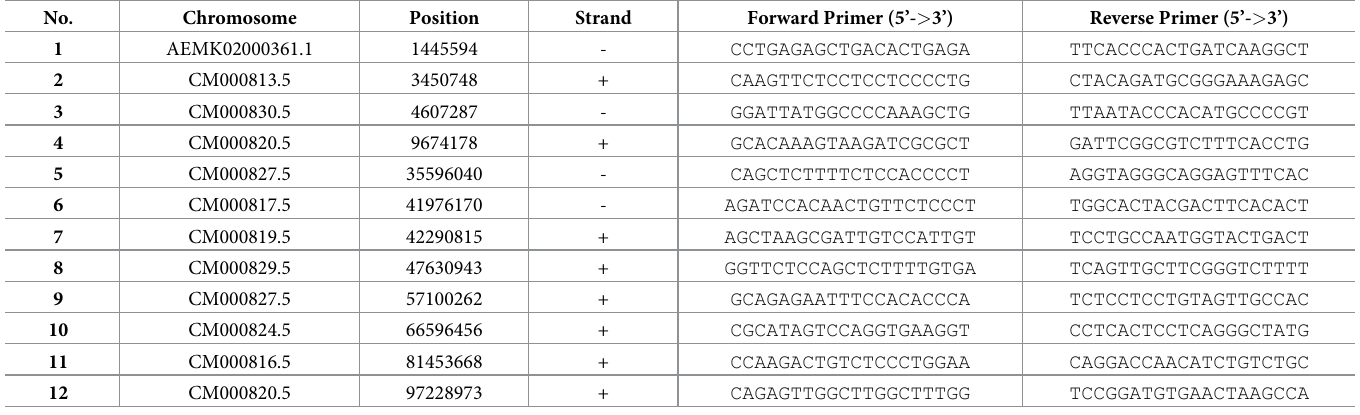
Table 3. Off target analysis sites evaluated for indel formation after CRISPR editing.